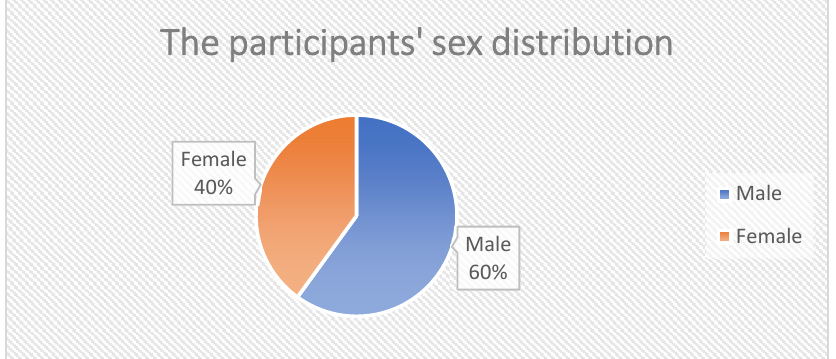
Figure 2. The participants’ sex distribution.